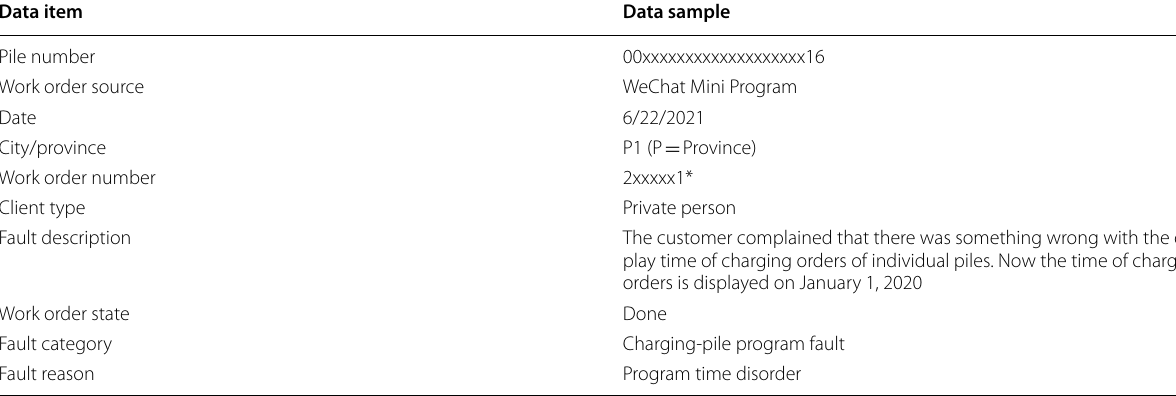
*Due to privacy reasons, we use ‘xxx’ to take the place of the actual